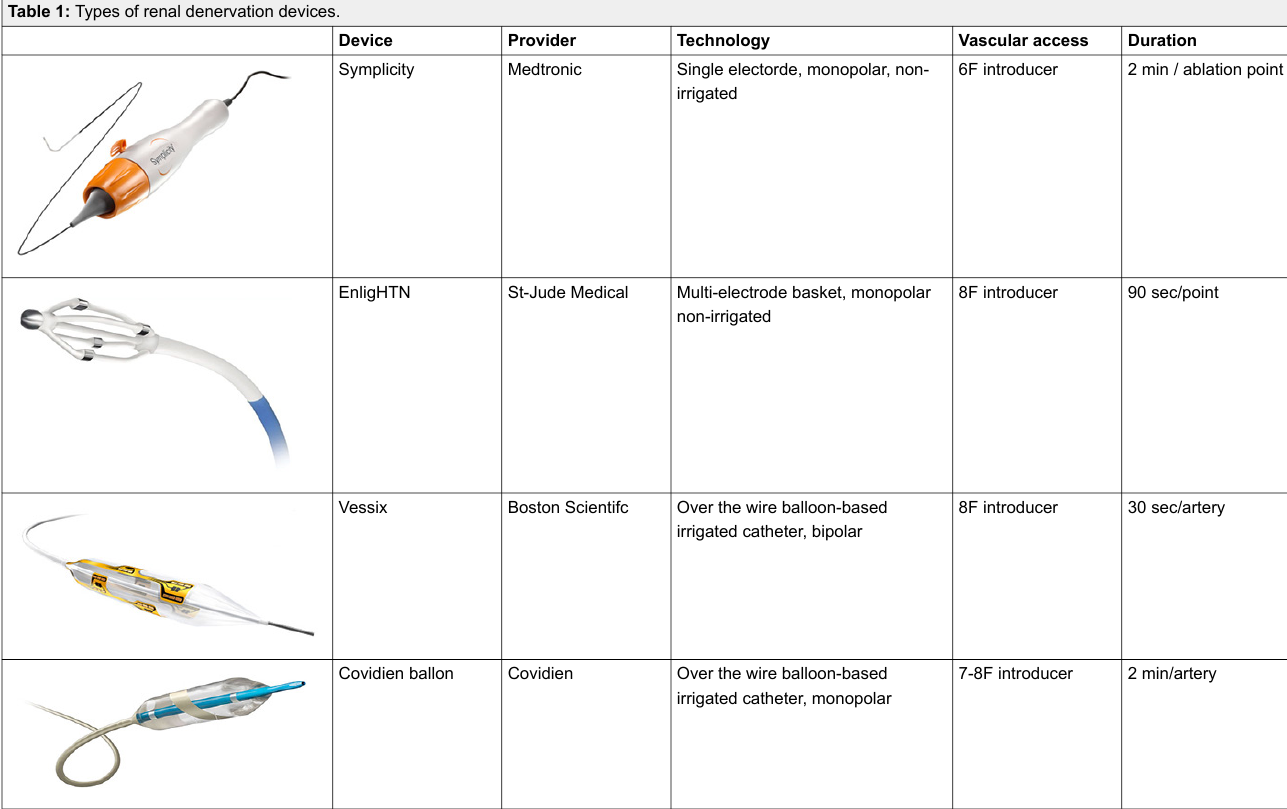
Table 1: Types of renal denervation